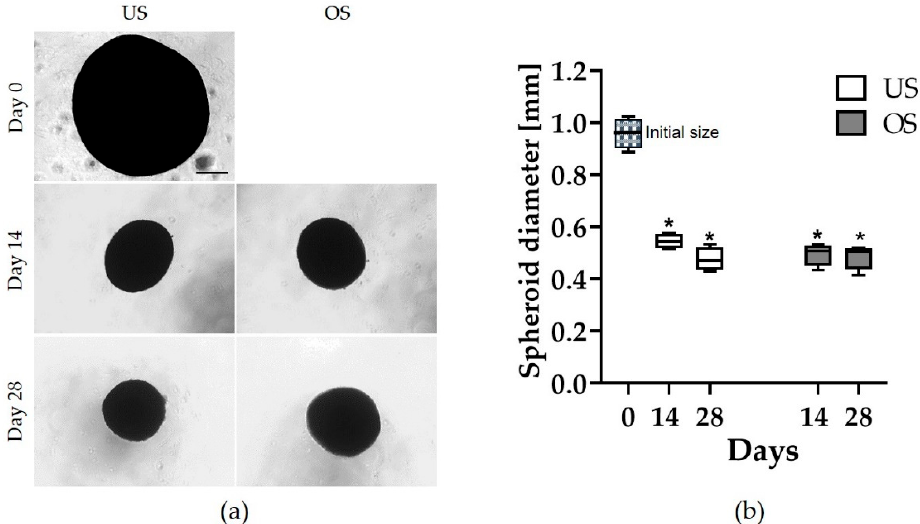
Figure 1. Spheroid morphology and analysis of the spheroid diameter. ( a ) Unstimulated (US) and osteogenically stimulated (OS) spheroids initially after spheroid formation (day 0) and after 14 and 28 days ( n = 4, phase contrast, Axiovert 25, scale bar: 200 µ m); ( b ) Analysis of the spheroid diameter of unstimulated and osteogenically stimulated spheroids at day 0 and after 14 and 28 days of cultivation (* significantly different from day 0, p < 0.0001; one-way ANOVA post hoc uncorrected Fisher’s LSD, with n = 4 for diameter measurement by image analysis using ImageJ ).